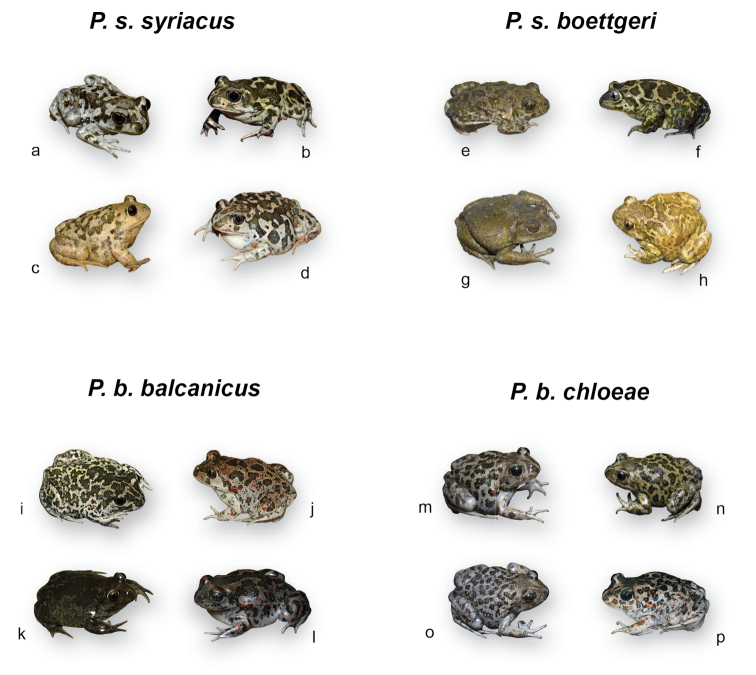
Color variation in Pelobatessyriacus and P.balcanicus. Photo credits and origins as follows a, b G Hamoivitch (Israël) c R Winkler (Israël) d G Martinez (Israël) e IS (Limnos, Greece) f SNL (European Turkey) g IS (Limnos, Greece) h A Nöllert (Dagestan, Russia) i MD (Danube Delta, Romania) j IS (Thrace, Greece) k IS (Macedonia, Greece) l IS (Evia, Greece) m–o IS (Peloponnese, Greece) p CD (Peloponnese, Greece).